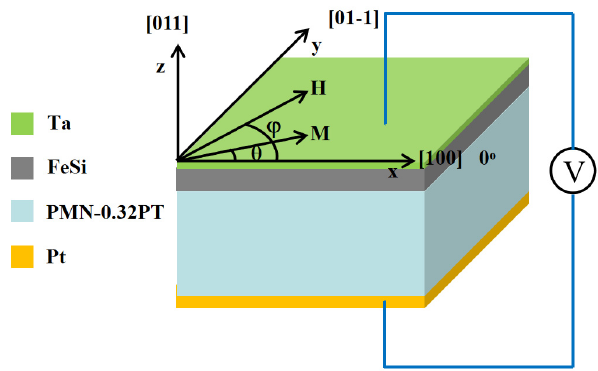
Figure 1. The coordinate system and schematic diagram of FeSi / (011) PMN-0.32PT heterostructures for the electric field control magnetization measurements.